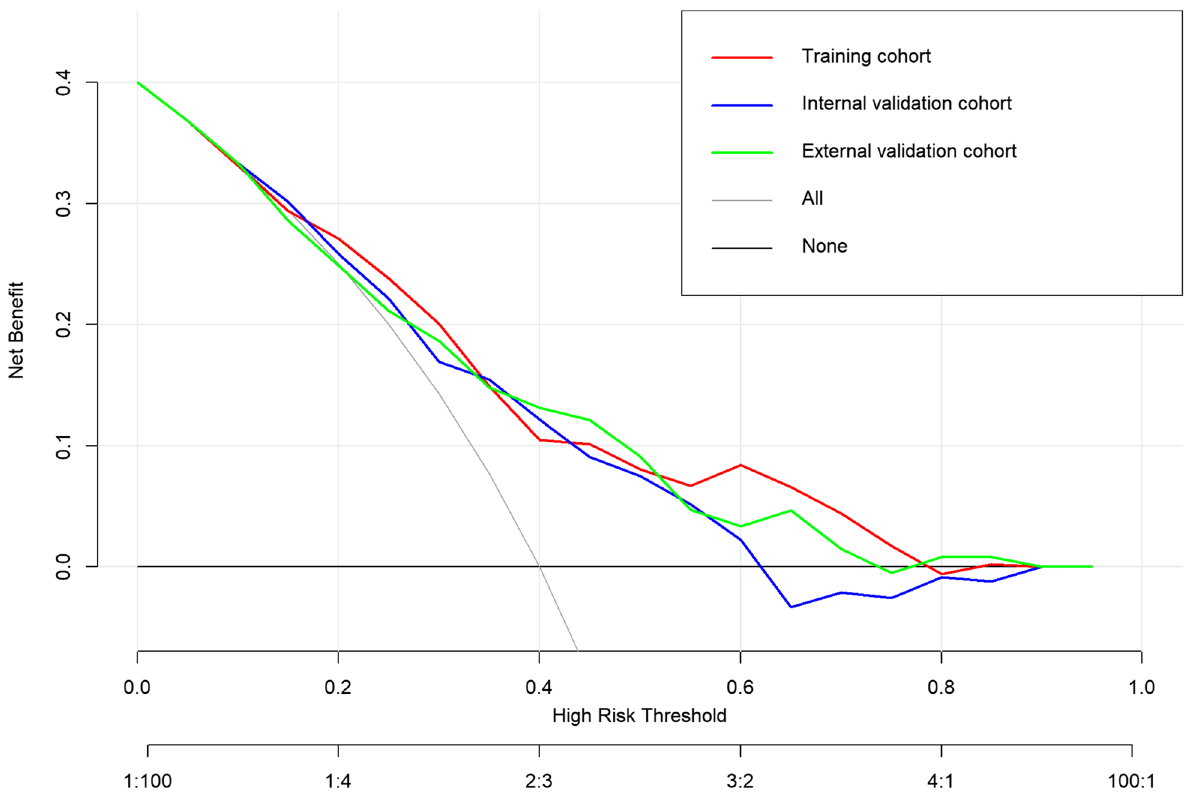
Fig. 3 Decision curves of the radiomics model in the training, internal validation, and external validation cohorts. The X-axis represents the threshold probability and the Y-axis is the net benefit. The black line “NONE” indicates that no lesions are assumed to be HER2-positive, and the gray line “ALL” indicates that all lesions are assumed to be HER2-positive. The model with higher clinical usefulness means it is further away from both the black and gray lines